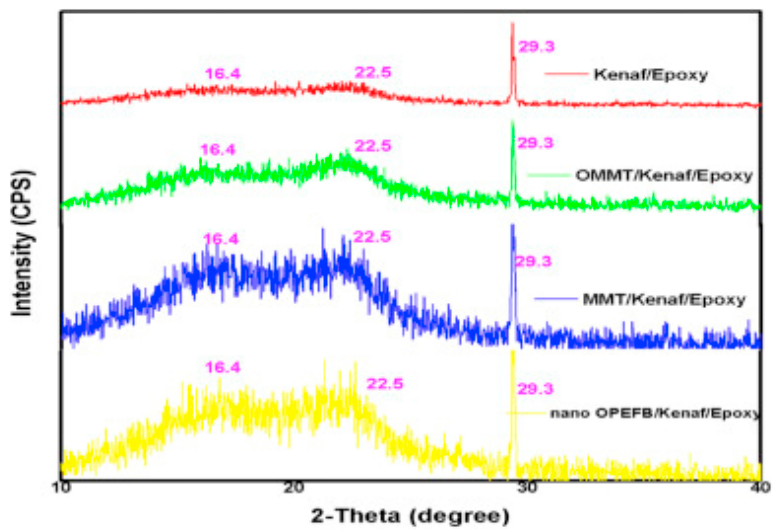
Figure 13. XRD-graph of kenaf/epoxy composites and filler-filled kenaf/epoxy hybrid nanocomposites [179] (Reprinted/adapted with permission from Elsevier Ref.501782938 Copyright 2018).